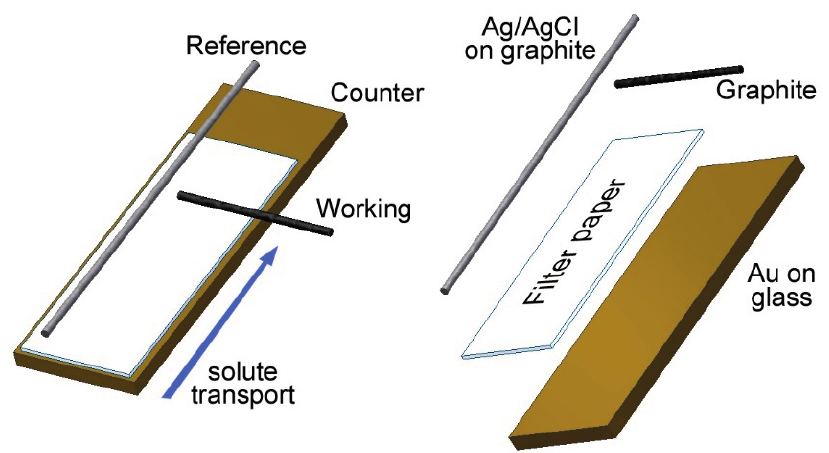
Figure 1. A schematic of our paper-based electrochemical